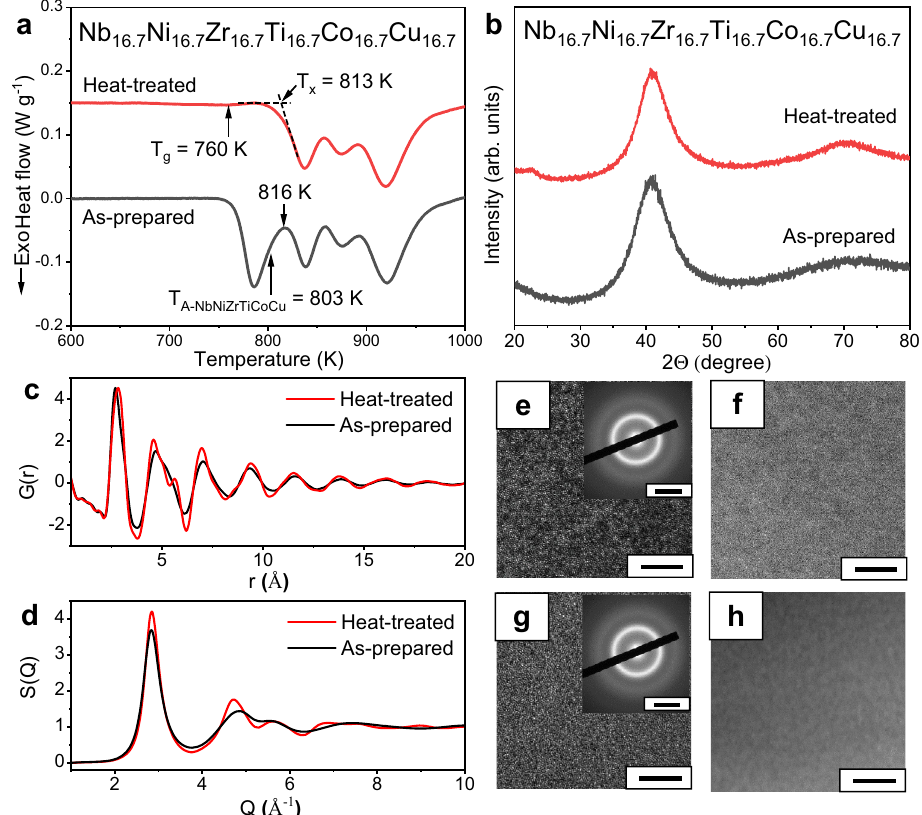
Fig. 8 DSC curve, X-ray diffraction, synchrotron X-ray diffraction, HRTEM, SAED, and HAADF analyses of the as-prepared and heat-treated NbNiZrTiCoCu HEMGs. a DSC curve of the as-prepared and heat-treated sample. After heated to T A-NbNiZrTiCoCu = 803 K, the previous fi rst exothermic peak disappears and the heat-treated sample shows a T g of 708 K and T x of 813 K. To highlight the phase transitions, the curve of the crystallized HEMG (samples heated to 1173 K) was subtracted. It should be noted that the fi rst two exothermal peaks (corresponding to the glass-to-glass transition